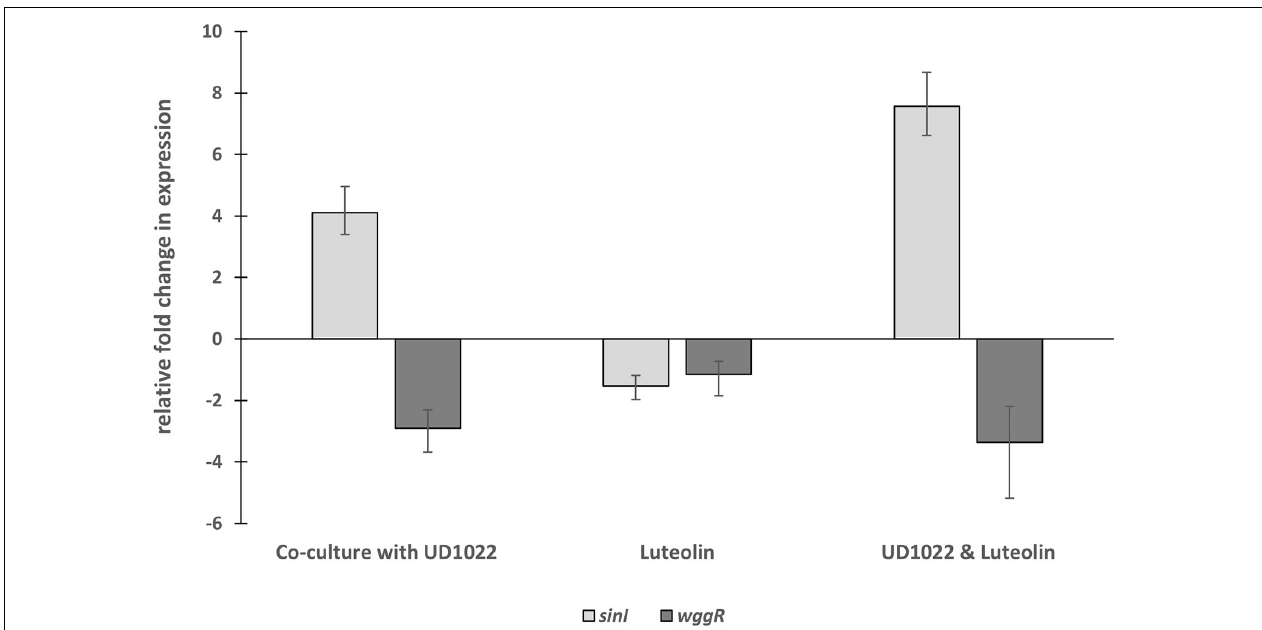
FIGURE 3 | Relative fold changes in expression of Rm8530 sinI and wggR in co-culture with UD1022. Co-culture with UD1022 increased the relative expression of Rm8530 sinI by 4-fold. The presence of luteolin (which represents the condition of Rm8530 upregulating nod genes) doubled the effect of UD1022 on Rm8530 sinI , increasing expression to nearly 8-fold. Luteolin alone did not meet the threshold of 2-fold change in Rm8530 sinI expression. Co-culture with UD1022 decreased the relative expression of Rm8530 wggR by 3-fold. The presence of luteolin slightly enhanced the effect of UD1022 on Rm8530 wggR , increasing to 3.4-fold. Luteolin alone did not change Rm8530 wggR expression. Standard error bars reflect the range of the relative fold change in gene expression in response to the